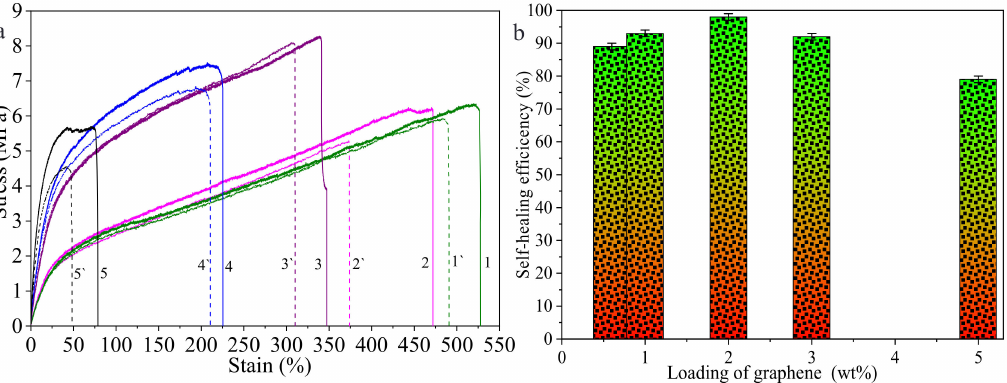
Figure 11. Stress–strain curves of the composite films with graphene loading of 0.1 wt% (1, 1 (cid:48) ), 0.6 wt% (2, 2 (cid:48) ), 1 wt% (3, 3 (cid:48) ), 2 wt% (4, 4 (cid:48) ), 3 wt% (5, 5 (cid:48) ) and 5 wt% (6, 6 (cid:48) ) before and after self-healing ( a ) and the self-healing efficiencies of the samples ( b